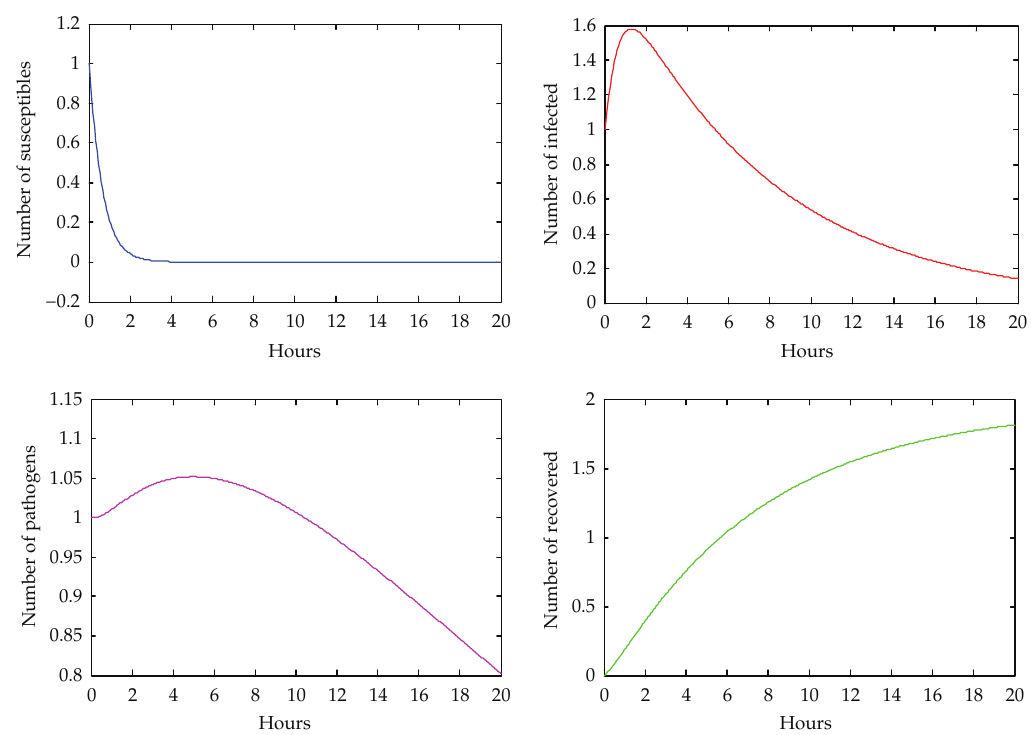
Figure 2: The e ff ect of optimal control with the number of susceptibles, infected individuals, pathogen con- centration, and the recovered individuals.